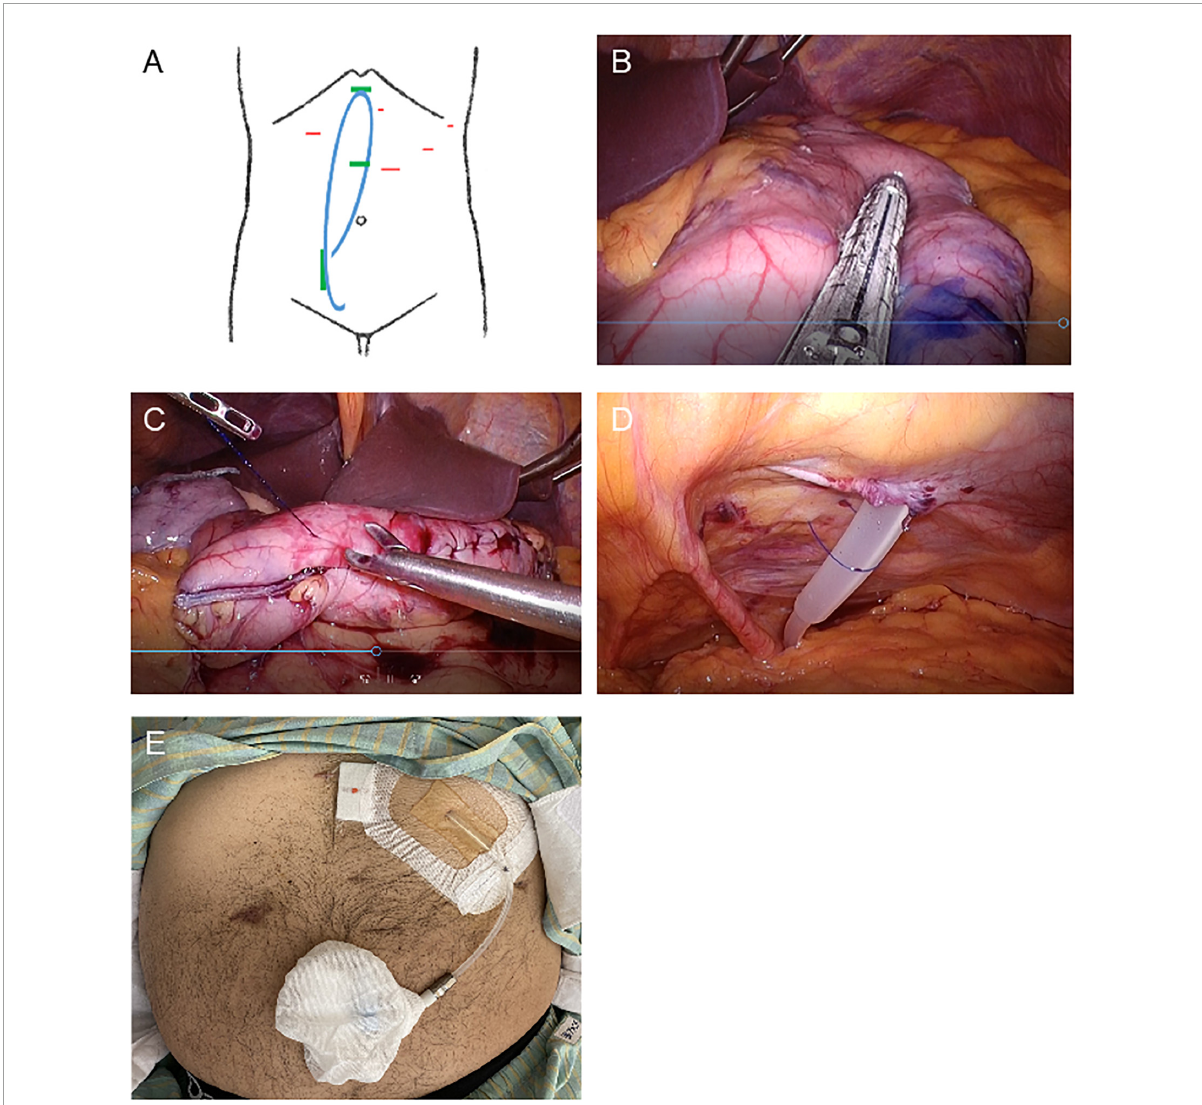
FIGURE2 Schematic images and intraoperative photographs of simultaneous laparoscopic sleeve gastrectomy and implantation of a buried peritoneal dialysis catheter. (A) Schematic designs of simultaneous laparoscopic sleeve gastrectomy and implantation of a buried peritoneal dialysis catheter. Red: location of trocar insertion. Blue: buried PD catheter. Green: PD catheter insertion and implantation site. (B–D) Intraoperative photographs. (B) Longitudinal sleeve gastrectomy from the antrum to the proximal His angle. (C) The stapler line sutured. (D) PD catheter sutured laparoscopically to the lower abdominal wall. (E) Photograph of the PD catheter exteriorized to the upper